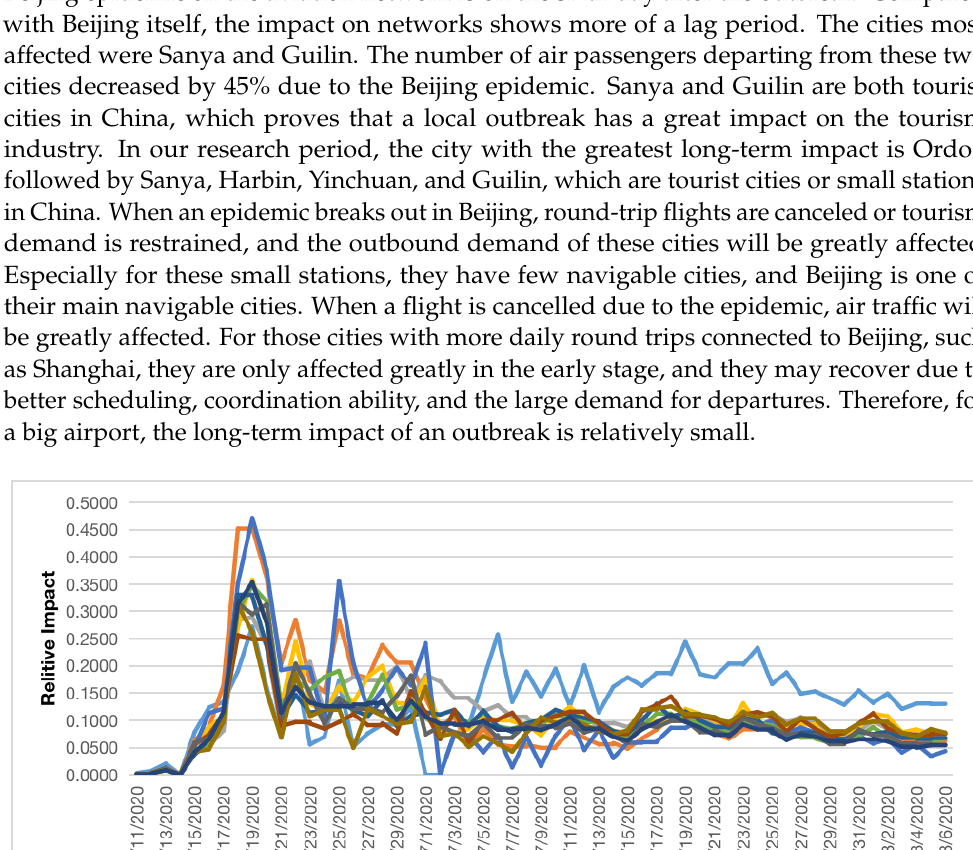
Figure 11. The impact of outbreaks in Beijing on air routes.